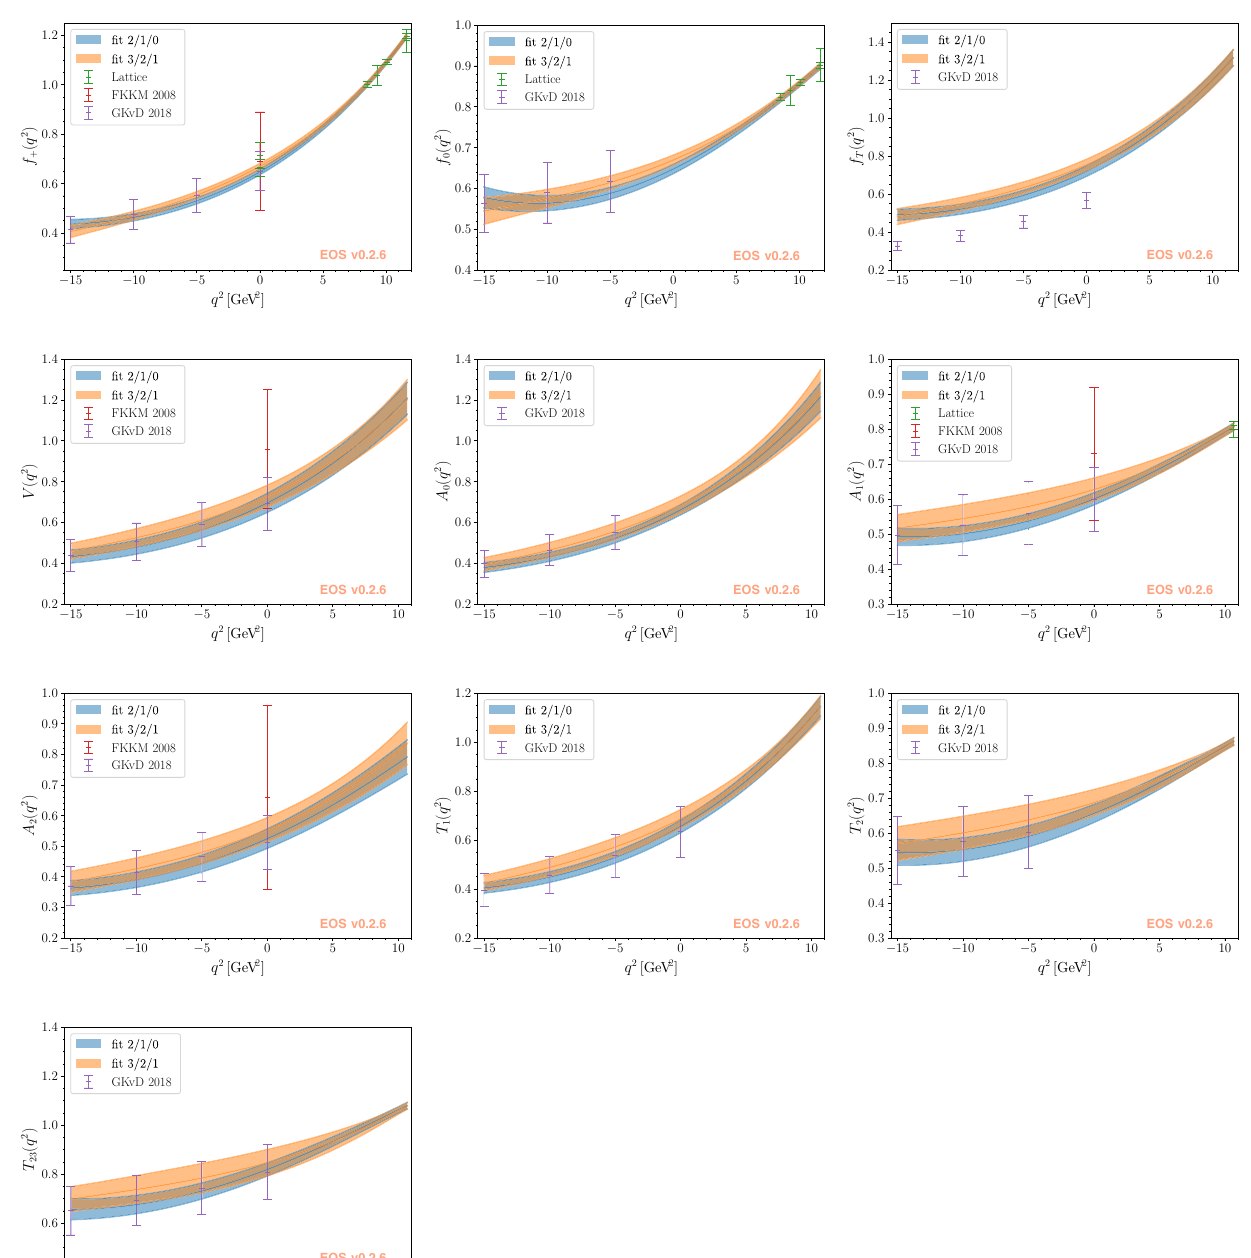
Fig. 1 The full set of ¯ B → D ( ∗ ) form factors as a function of q 2 are used to showcase our results for the nominal fit model 3 / 2 / 1 (orange lines and areas), in comparison to the minimal viable fit model 2 / 1 / 0 (light blue lines and areas). For both models we show the central values and 68% probability envelopes from posterior-predictive distributions